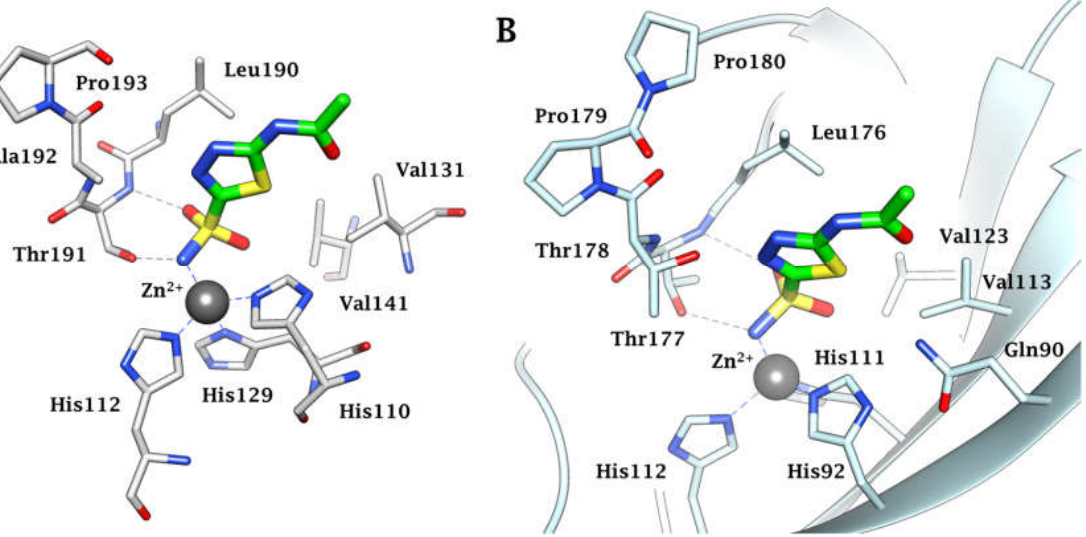
Figure 6. ( A ) Active site view of the α-CA of Helicobacter pylori in adduct with AAZ (4YGF). ( B ) Active site ribbon view of the α-CA of N. gonorrhoeae in adduct with AAZ (8DYQ). H-bonds are represented as black dashed lines.